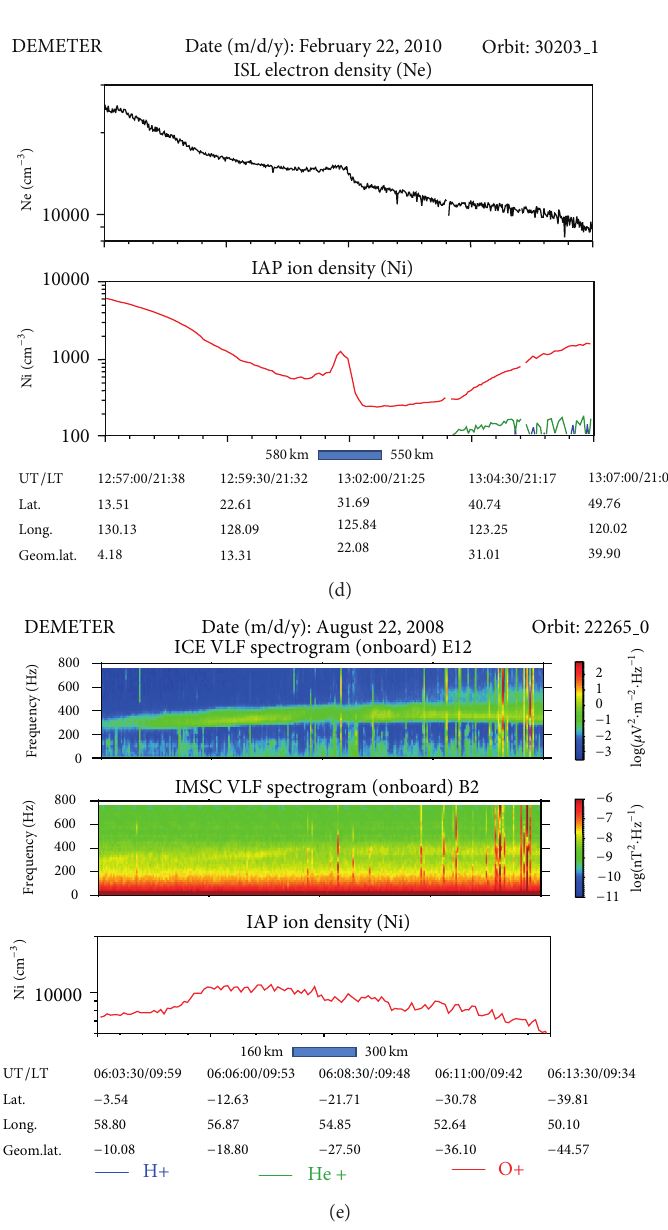
Figure 2: (a) Example of type 1 anomaly. Electric anomaly recorded on Poas volcano on November 20, 2009, 35 days before the beginning of the eruptive activity. From top to bottom: Spectrogram of the electric field up to 500 Hz (the intensity is colour-coded according to the scale on the right), spectrogram of the magnetic field up to 500Hz, and ion densities (H+ in blue, O+ in red, and He+ in green). The closest approach to the volcano is between 03:18:30 (90 km) and 03:19:30 UT (120km). The blue rectangular indicates how the distance of the footprint of the satellite moves. (b) Example of type 2 anomaly. Electric (top panel) and magnetic (bottom panel) anomalies recorded on Asama volcano on December 30, 2008, 22 days before the eruption. The electric spectrogram is up to 15kHz, whereas the magnetic one is up to 1kHz. The closest approach to the volcano is at 01:07:30 UT (15km). The blue rectangle that indicates how the distance of the footprint of the satellite moves. (c) Example of type 3 anomaly. Time elongated electric anomaly recorded on Soputan volcano on May 26, 2008, 10 days before theonset of surface activity. Electric (top panel) and magnetic (bottom panel) spectrograms are up to 300 Hz. The closest approach to the volcano is at 13:44:30 UT (35 km). The blue rectangular indicates how the distance of the footprint of the satellite moves. (d) Example of type 4 anomaly. Change in electronic (top panel) and ionic (bottom panel (O+ in red, and He+ in green)) densities recorded on Kirishima volcano on February 22, 2010, 36 days before the surface activity started. The closest approach to the volcano is at 13:02:00 UT (470km). The blue rectangular indicates how the distance of the footprint of the satellite moves. (e) Example of type 5 anomaly. Decrease of the energy content in the electric and magnetic fields recorded on La Fournaise volcano on August 31, 2008, 21 days before beginning of opening of active fissures. From top to bottom: spectrogram of the electric field up to 800 Hz (the intensity is colour-coded according to the scale on the right), spectrogram of the magnetic field up to 800Hz, and the O+ density. The closest approach to the volcano is at 06:08:30 UT (105km). The blue rectangular indicates how the distance of the footprint of the satellite